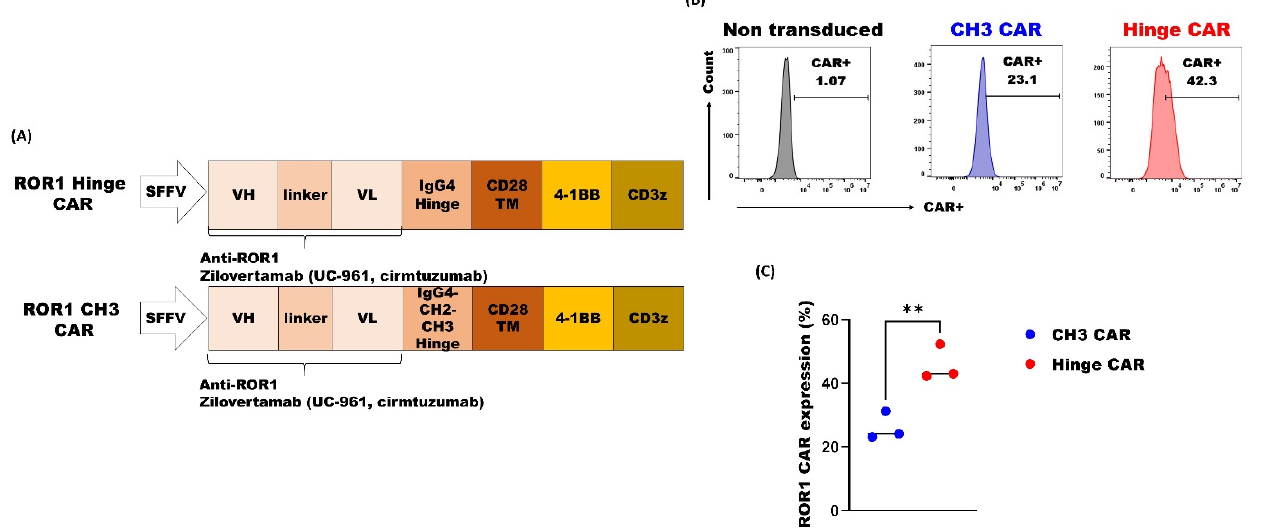
Figure 2. ROR1 CAR with shorter spacer exhibited superior expression. ( A ) The schematic ROR1 Hinge CAR and ROR1 CH3 CAR constructs; ( B ) The expression of CARs was detected with recombi- nant ROR1 protein on Jurkat-lucia 3 days after lentivirus transduction and analyzed by flow cytometry, a representative of more than 3 experiments; ( C ) ROR1 CAR expression rates from 3 independent experiments (** p < 0.01).